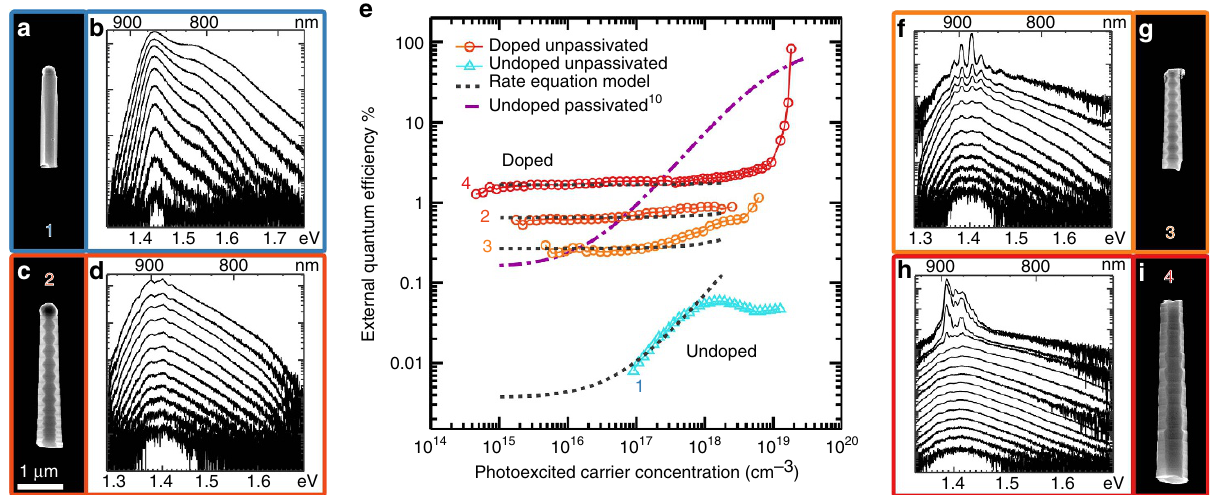
Figure 3 | Absolute quantum efficiency measurements. ( a ) SEM image of an undoped GaAs NW and ( b ) corresponding power-dependent PL spectra. ( c ) SEM image of a doped TSL GaAs NW and ( d ) corresponding power-dependent PL spectra. ( e ) External quantum efficiency of the NWs shown in a , c , g and i . Fits of rate equation modelling are also plotted along with the modelled performance of undoped AlGaAs passivated GaAs NWs previously shown to lase at room temperature in ref. 10. ( f ) Power-dependent PL spectra of a doped TSL GaAs NW and ( g ) a corresponding SEM image. ( h ) Power- dependent PL spectra of a doped aperiodically twinned GaAs NW and ( i ) a corresponding SEM image. All SEM images are shown at the same magnification. Scale bar, 1 m